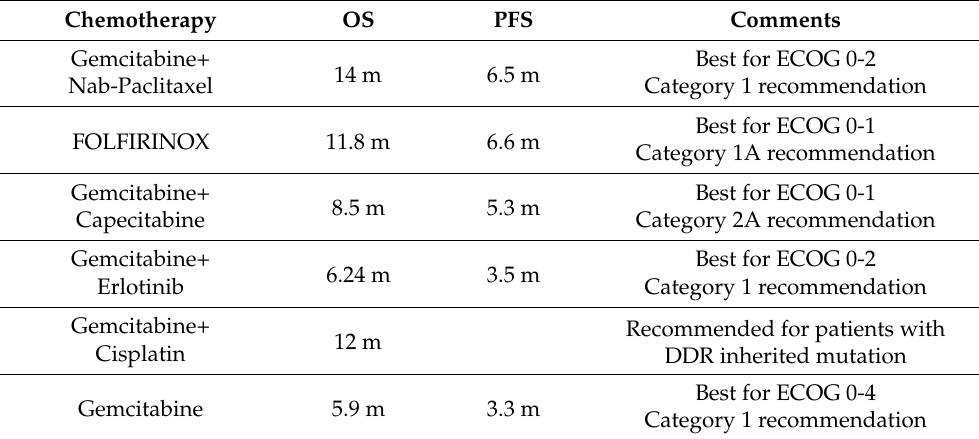
Table 2. The most common chemotherapy used in the treatment of metastatic pancreatic ductal adenocarcinoma